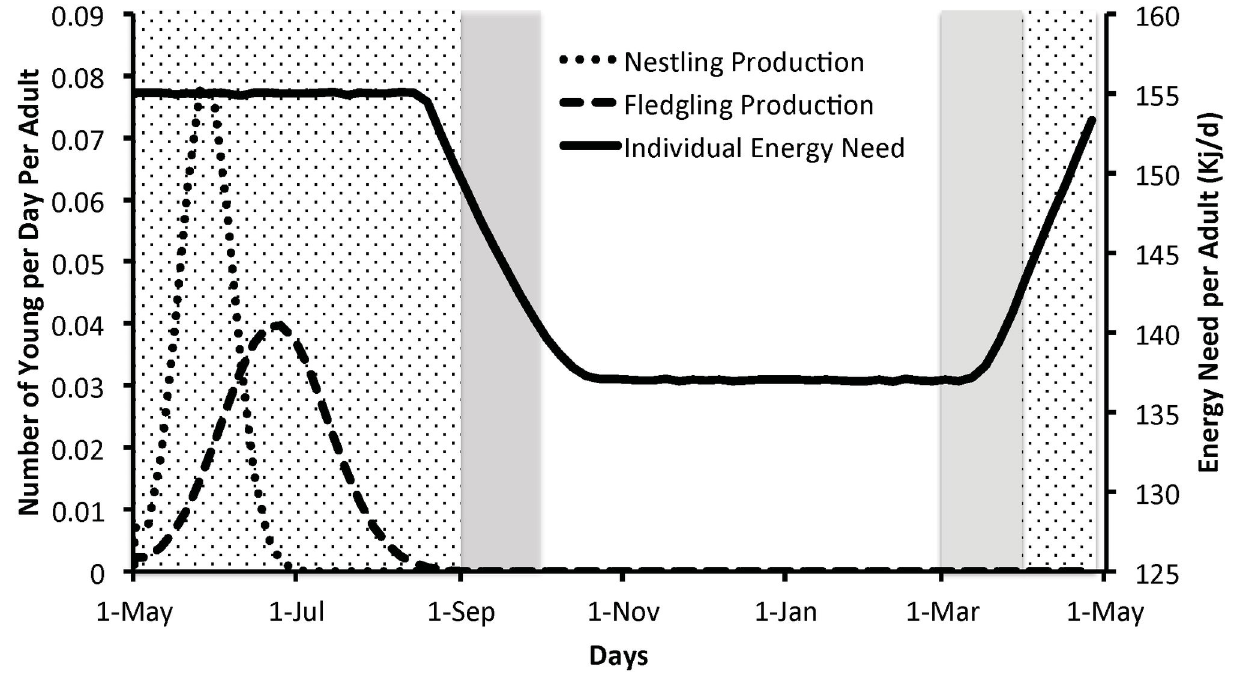
Figure 1. Phenology of energy need of adult Purple Martins (solid line), nestling production per adult (dotted line), and fledgling production per adult (dashed line) across one year. Background shading indicates phase of the annual cycle as breeding season (stippling), migration (gray), and winter (no shading). doi: